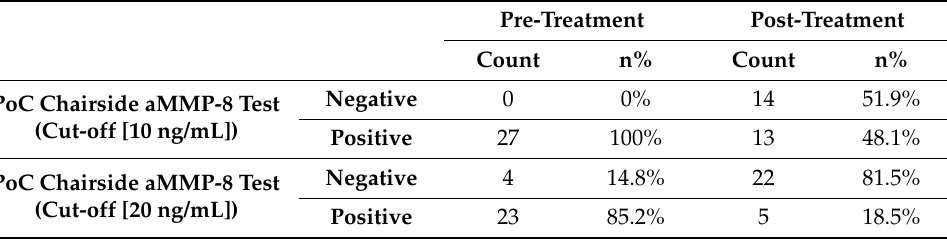
Table 3. Cut-off calculated by Youden’s